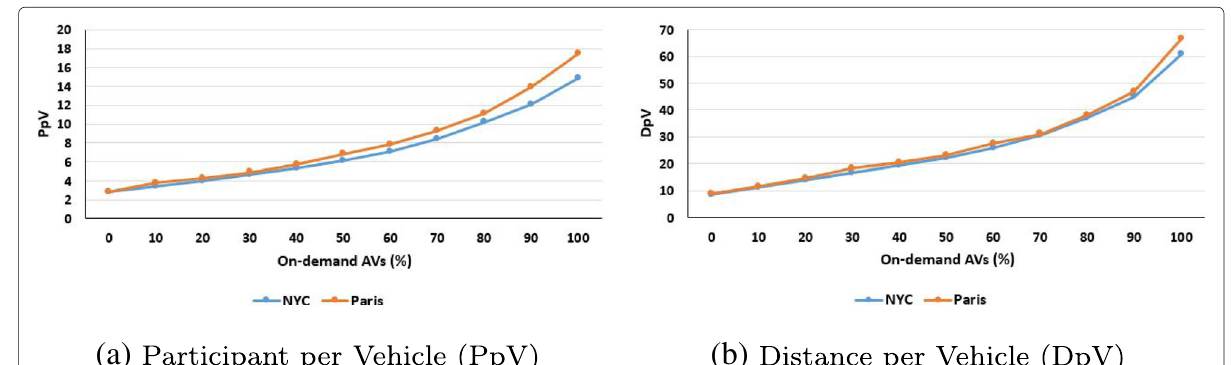
Fig. 12 Participant and Distance per Vehicle (%). a Participant per Vehicle (PpV) b Distance per Vehicle